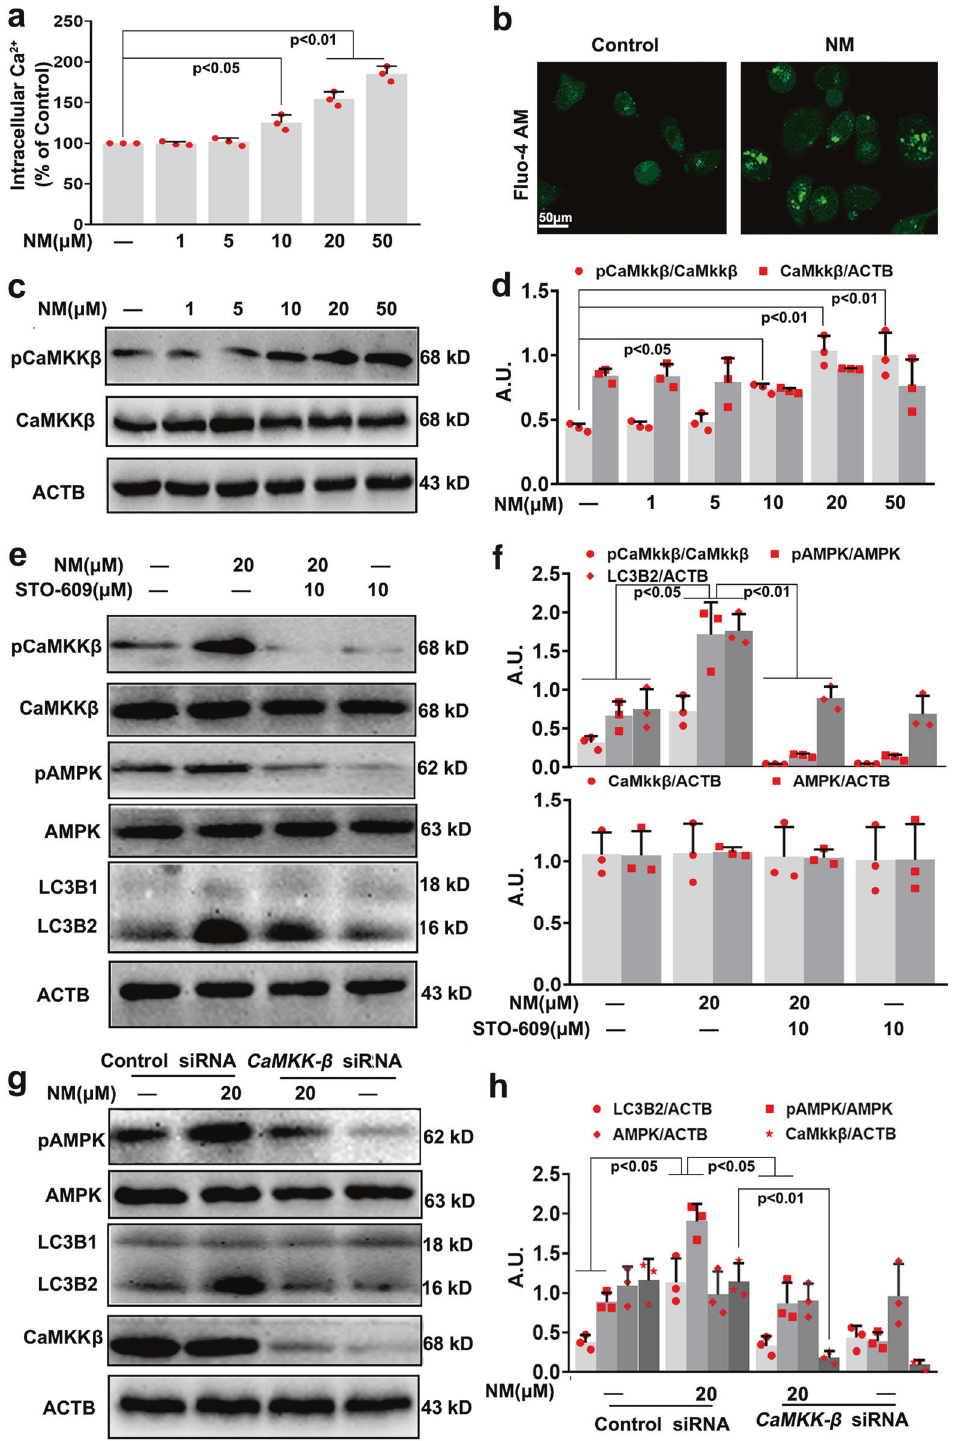
Fig. 6 NM-activated AMPK via the Ca 2 + -CaMKK β pathway in keratinocytes. a Cells were treated with NM at a series of concentrations (1, 5, 10, 20, and 50 µM) for 24 h. The intracellular Ca 2 + content was measured with Fluo-4 AM by an In fi nite TM M200 Microplate Reader, according to the manufacturer ’ s instructions. b Representative images of intracellular Ca 2 + detected with a Radiance 2000 laser scanning confocal microscope. c Cells were treated as described in ( a ) and the expression of pCaMKK β and CaMKK β was measured by western blotting. d The bar graphs show the quanti fi cation of endogenous pCaMKK β . e Cells were pretreated with STO-609 (10 µM) for 1 h followed by exposure to NM (20 µM) for an additional 24 h. Cells were collected and lysed, then western blot analysis was performed. f The bar graphs show the quanti fi cation of the indicated proteins. g CaMKK β was knocked down by CaMKK β siRNA as described in “ Materials and methods ” . At 24-h post-transfection, the cells were treated with NM (20 µM) for 24 h. Cells were collected and lysed, then western blot analysis was performed. h The bar graphs show the quanti fi cation of the indicated proteins. Values are expressed as the means ± SD ( n = 3); A.U. arbitrary units